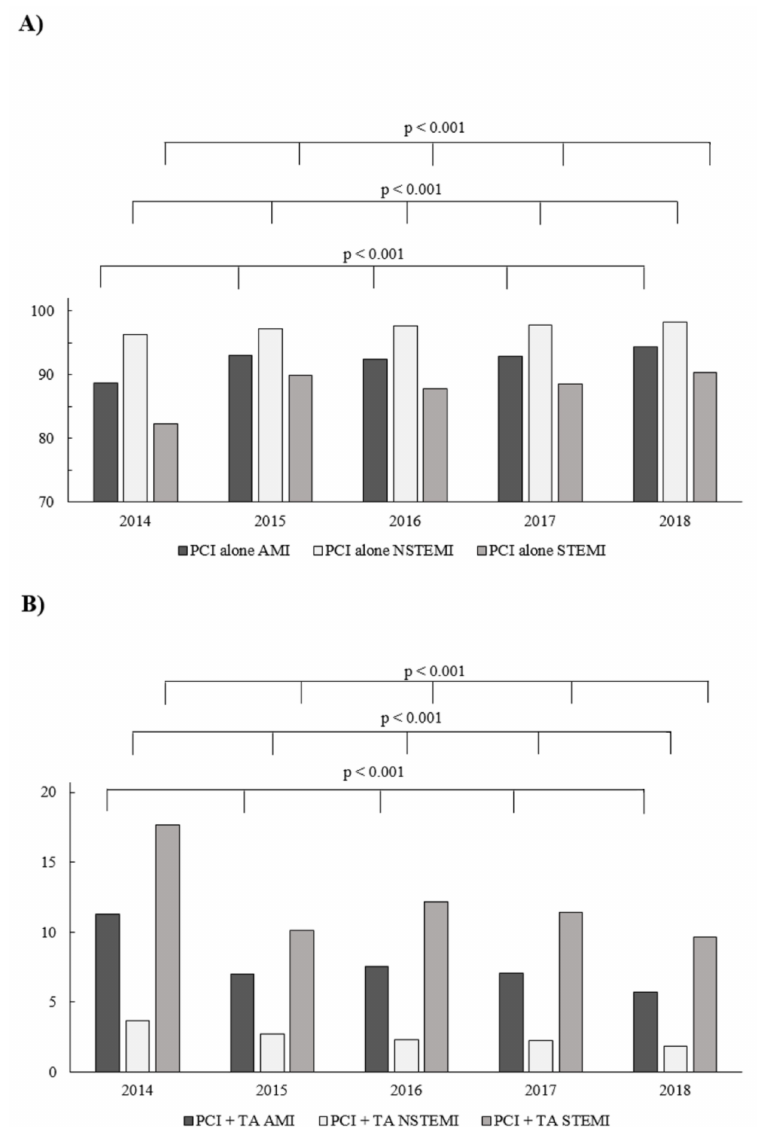
Figure 1. ( A ) The percentage of non-thrombectomy percutaneous coronary interventions (PCIs) according to type of acute myocardial infarction (AMI) in consecutive years (2014–2018) among patients treated with pPCI. ( B ) The frequency of thrombus aspiration (TA) according to type of AMI in consecutive years (2014–2018) among patients treated with primary PCI